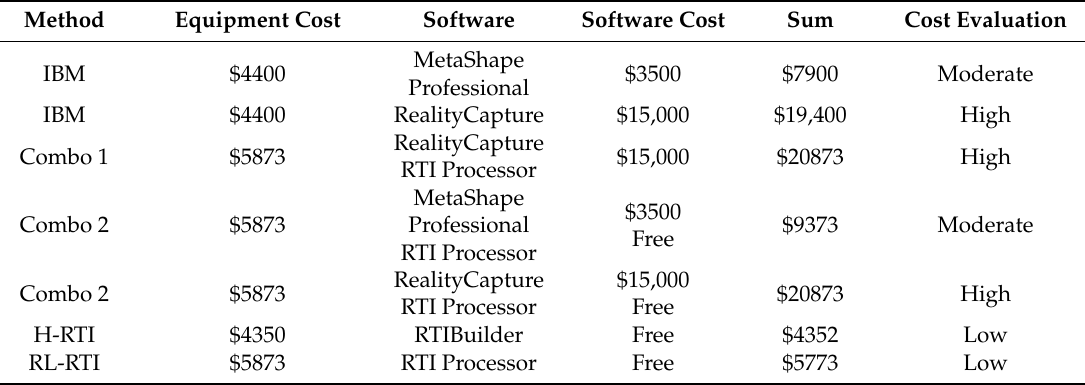
Table 3. The cost of equipment and software used. The evaluation of cost is subjectively evaluated on the following scale: Low (0–$7000), moderate ($7000–$14,000) or high ($14,000 or more). See Appendix A for details. The prices are as of February 2020, some of which have been converted from Norwegian Kroner or